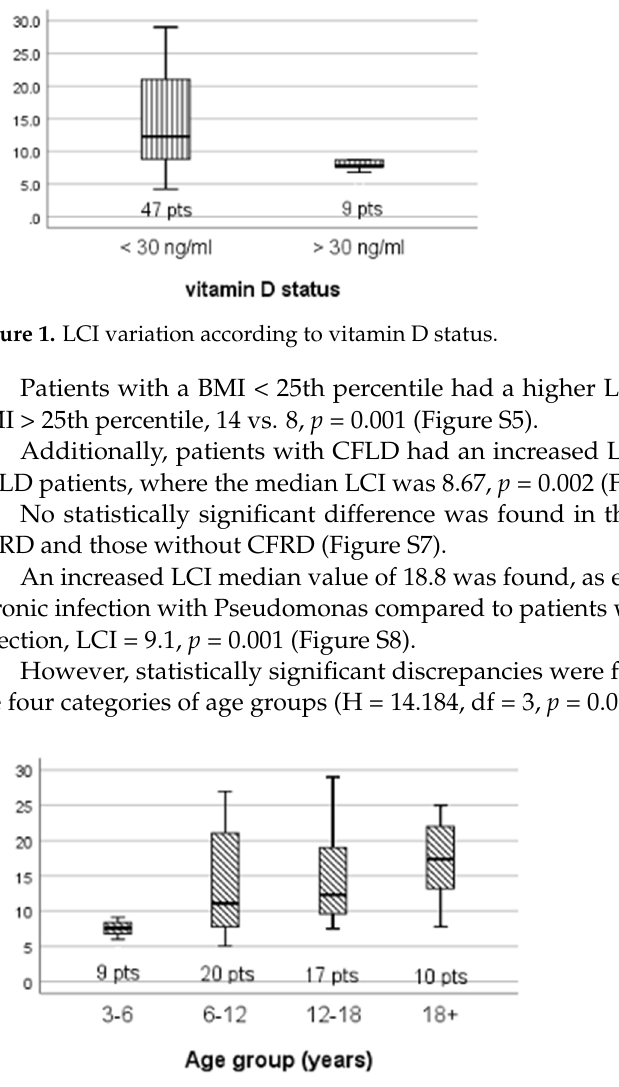
Figure 2. LCI variation according to age group.